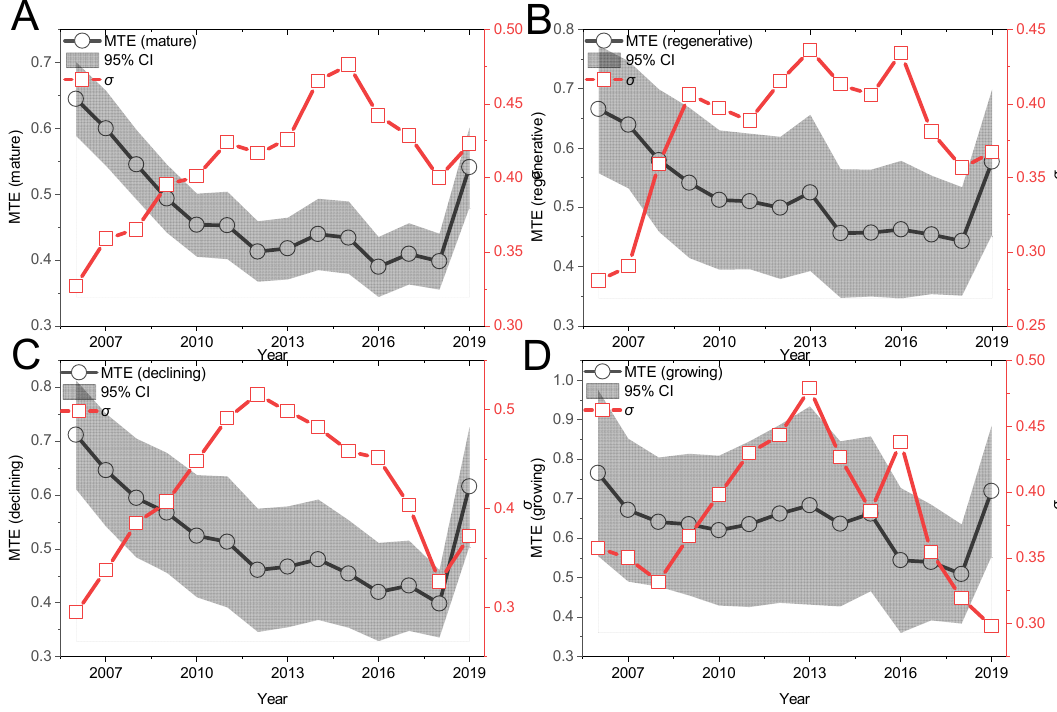
Figure 2. The trend of MTE in four types of mining cities from 2006 to 2019. Note: ( A – D ) represent mature, renewable, declining and growing mining cities respectively. The shaded area represents the 95% confidence interval (CI). σ Represents the convergence trend of MTE annual mean